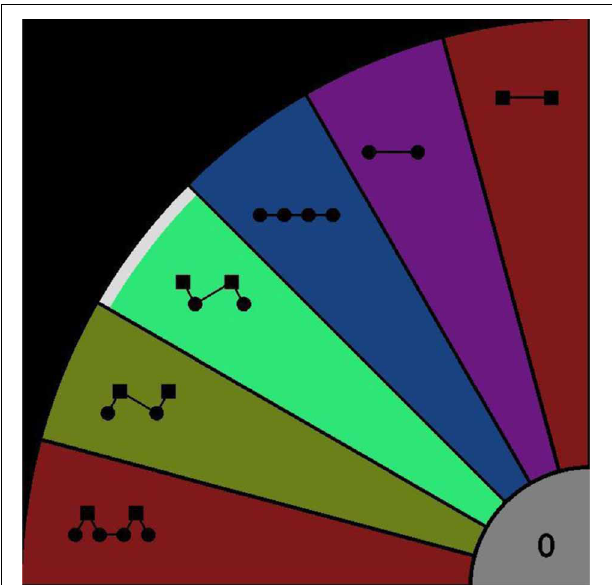
FIGURE 2 | Response interface. Participants were instructed to press the colored area corresponding to their dominant (foreground) percept, as indicated by the icons. Starting from the lowest area these patterns can be expressed using letters as ABA-, AB--, -BA-, A-, A---, B---, confused (gray area “0”). In this screen shot, the -BA- pattern is being reported as the currently perceived pattern (indicated by higher intensity and the white segment at the outer edge of the